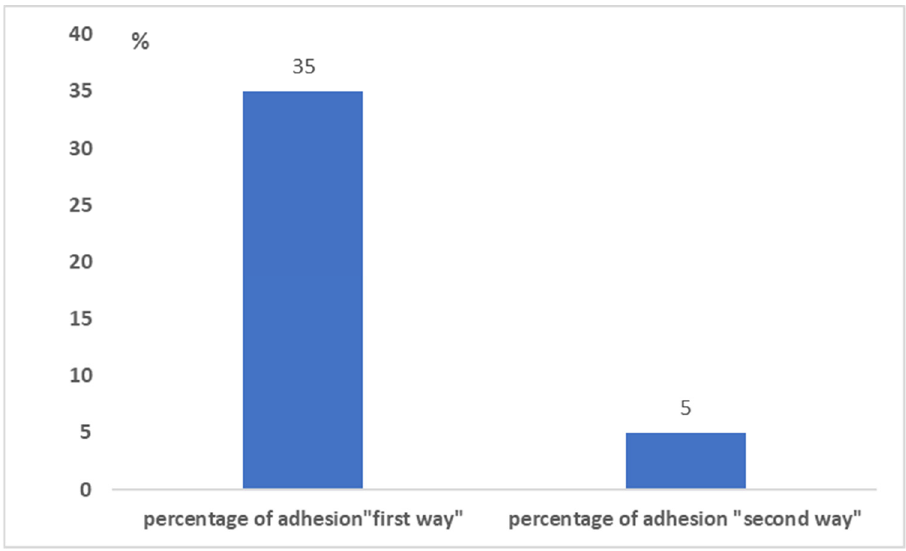
Figure 5. The percentage of adhesion to the survey by the two different